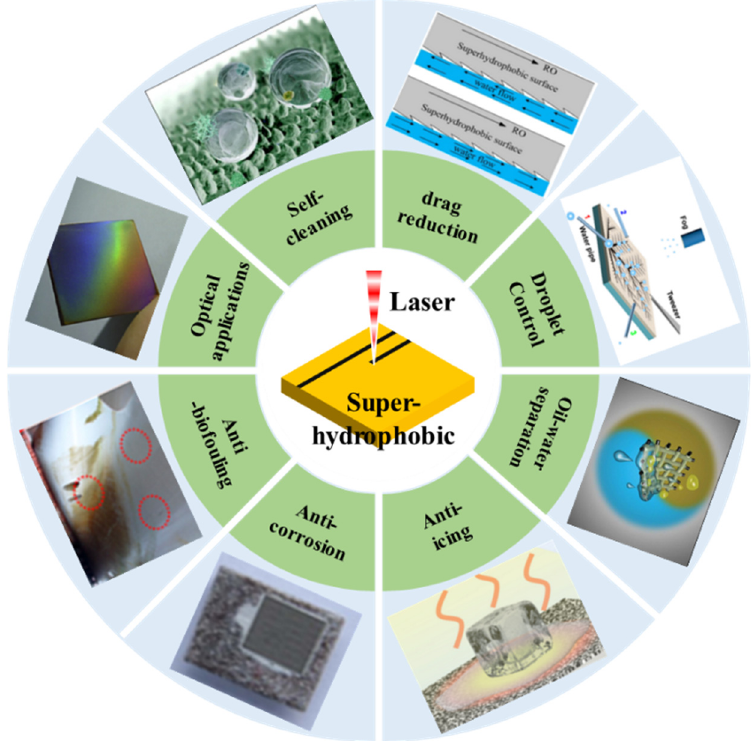
Figure 4. Industrial applications of functional surfaces prepared by laser micromachining.